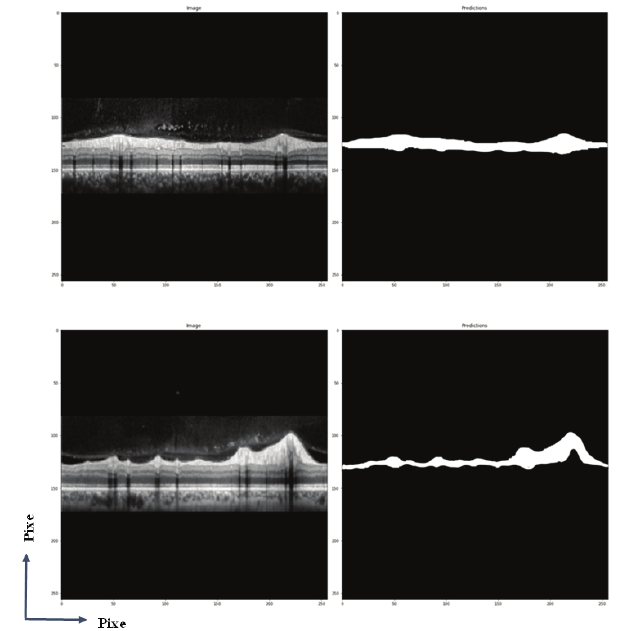
Figure 5. U-net prediction for two samples of the test set. Original image and U-net